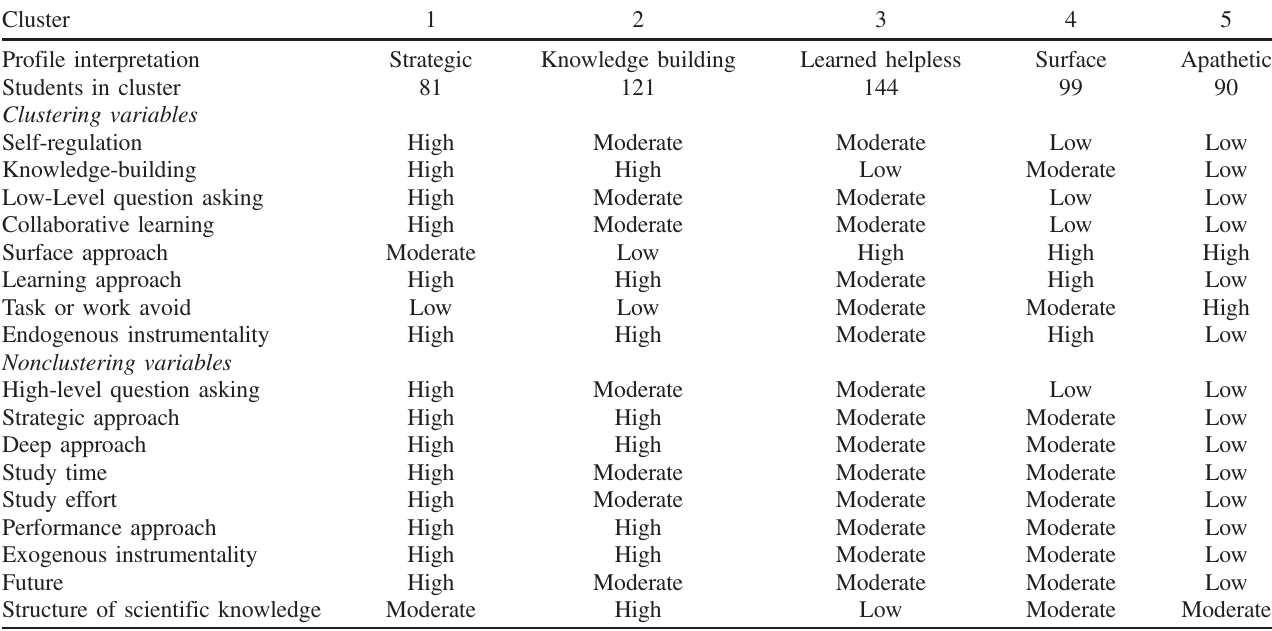
TABLE IV. Comparative scale rankings across clusters and learning profile interpretations.